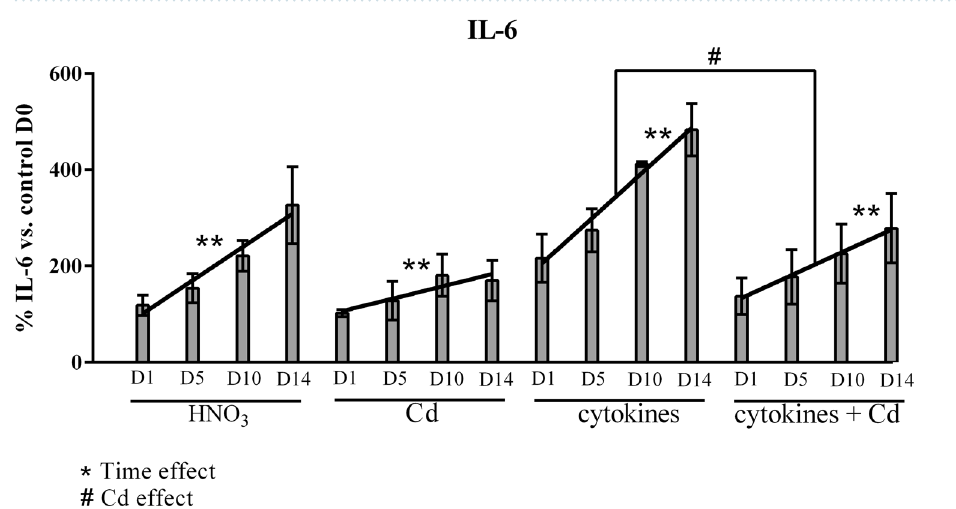
Figure 6. IL-6 production in supernatants from PVNS synovial tissue at different timepoints after Cd exposure. Supernatants from PVNS synovial tissues from three patients were collected at day 0, 1, 5, 10 and 14 after the treatment with 1 ppm of Cd with or without addition of the combination of pro-inflammatory cytokines (IL-17: 50 ng/ml and TNF: 1 ng/ml). IL-6 production was quantified by ELISA. Results are presented as mean ± SD. n = 3 from 3 PVNS synovial